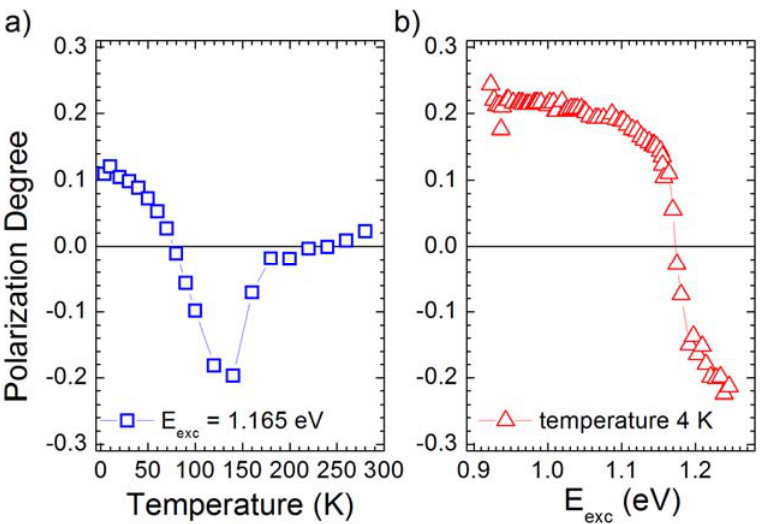
Figure 5. Photoluminescence polarization degree dependences for a p ‐ type bulk Ge wafer upon temperature ( a ) [139] and excitation energy ( b ) [146]. Adapted with permission from [139], Copyright the American Physical Society, 2013. Adapted with permission from [146], Copyright the American Physical Society, 2015.